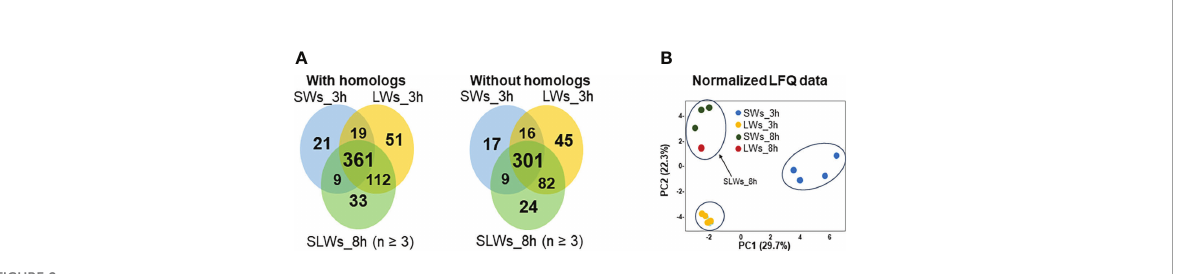
FIGURE 2 (A) Venn diagrams comparing the number of shared and unique E/S proteins (with/without the protein homologs) produced by the SWs, LWs and SLWs after three or eight hours of incubation at 37°C. SWs = small-size tapeworms, LWs = large-size tapeworms, SLWs = combined identi fi cation list containing three SWs-associated E/S protein datasets and one LWs-associated E/S protein dataset. (B) PCA investigating the relationships between the protein abundance patterns between the indicated E/S proteomes at three- and eight-hour time